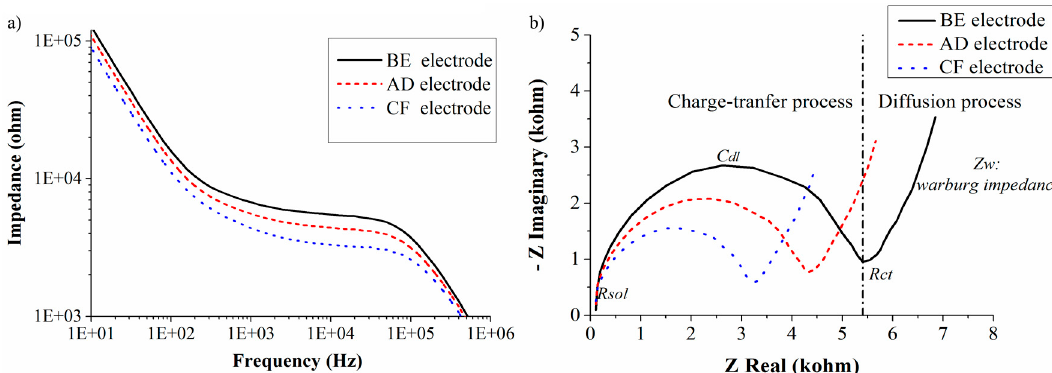
Figure 8. ( a ) Impedance response represented in Bode plot for 200 µL of PDA agar medium measured with different electrode configurations; ( b ) Impedance response in Nyquist plot for 200 µL PDA agar medium measured with three electrode configurations. Vertical dotted line shows the separation of physical process for BE electrode configuration. Both plots show the frequency range of 1 Hz to 1 MHz.